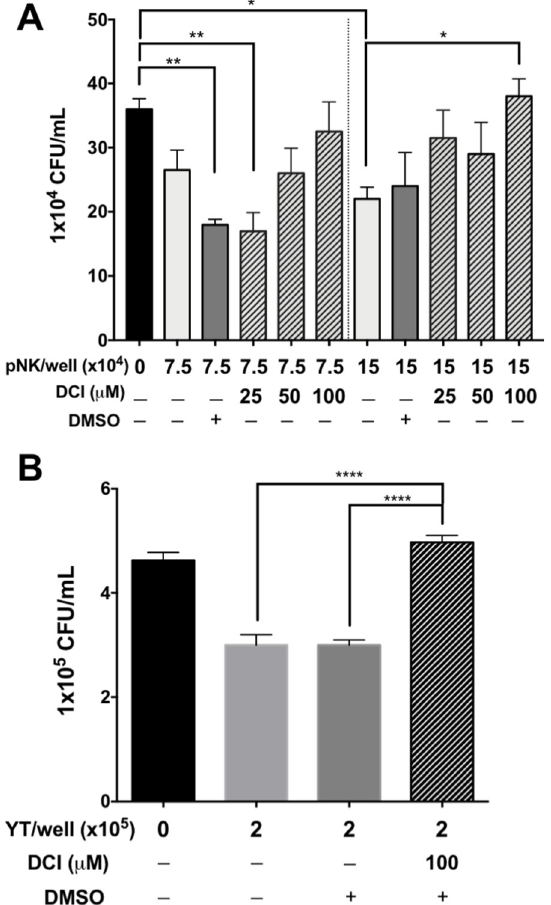
Fig 5. Inhibition of serine proteases abrogates killing in pNK and YT cells. PAO1(1000 CFU/well) incubated alone or in the presence of pNK (A) or YT cells (B) for 6 h before determining CFU. pNK or YT cells were pre-treated with 3,4-Dichloroisocoumarin (DCI) for 1 h to inhibit the serine proteases, including granzymes. Conditions were carried out in n = 4 wells (mean ± SEM) and the graph is representative of n � 3 biological replicates � = P � 0.05, �� = P � 0.01, ��� = P �